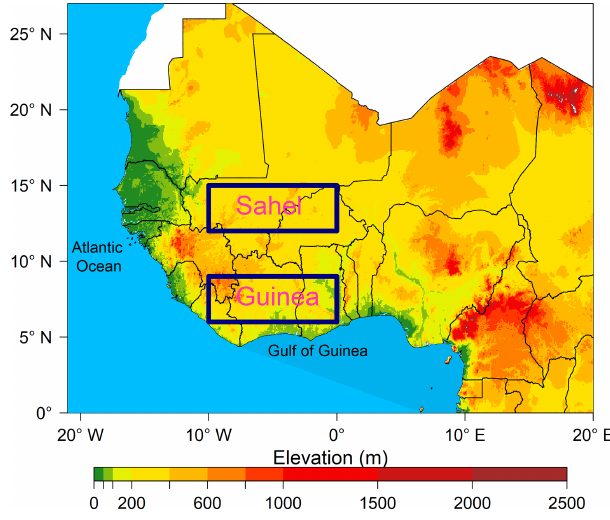
Figure 1. Map of West Africa showing the two selected windows (dark blue rectangles) used for identification of LLC events. The name denoted for each window is based on the climate zone of the window in the